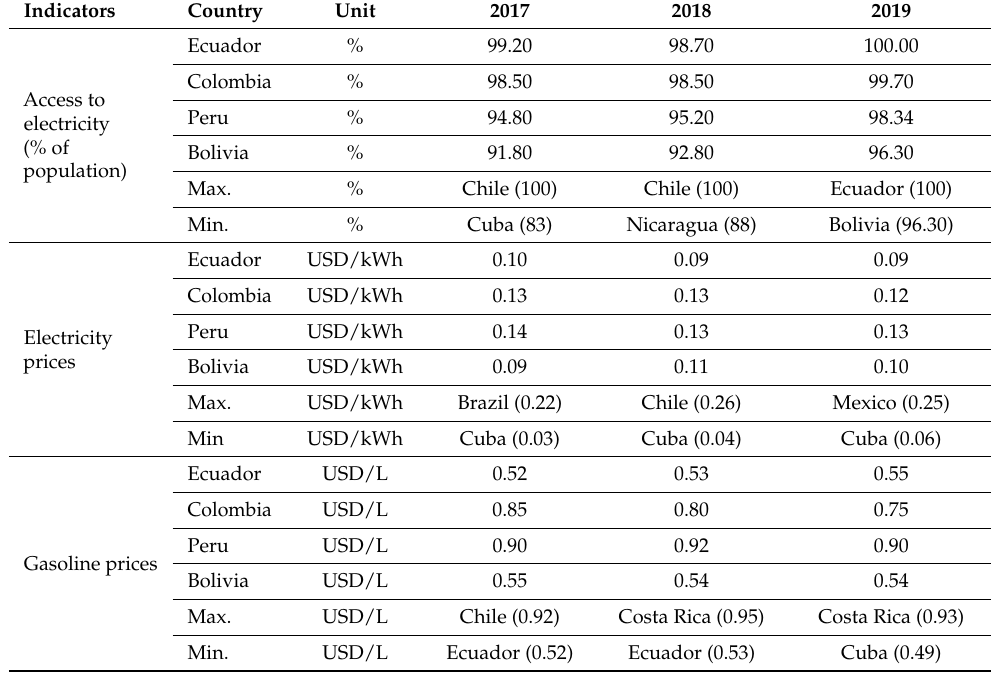
Table 6. The key indicators of the energy equity dimension in the members of the Andean Community (in absolute